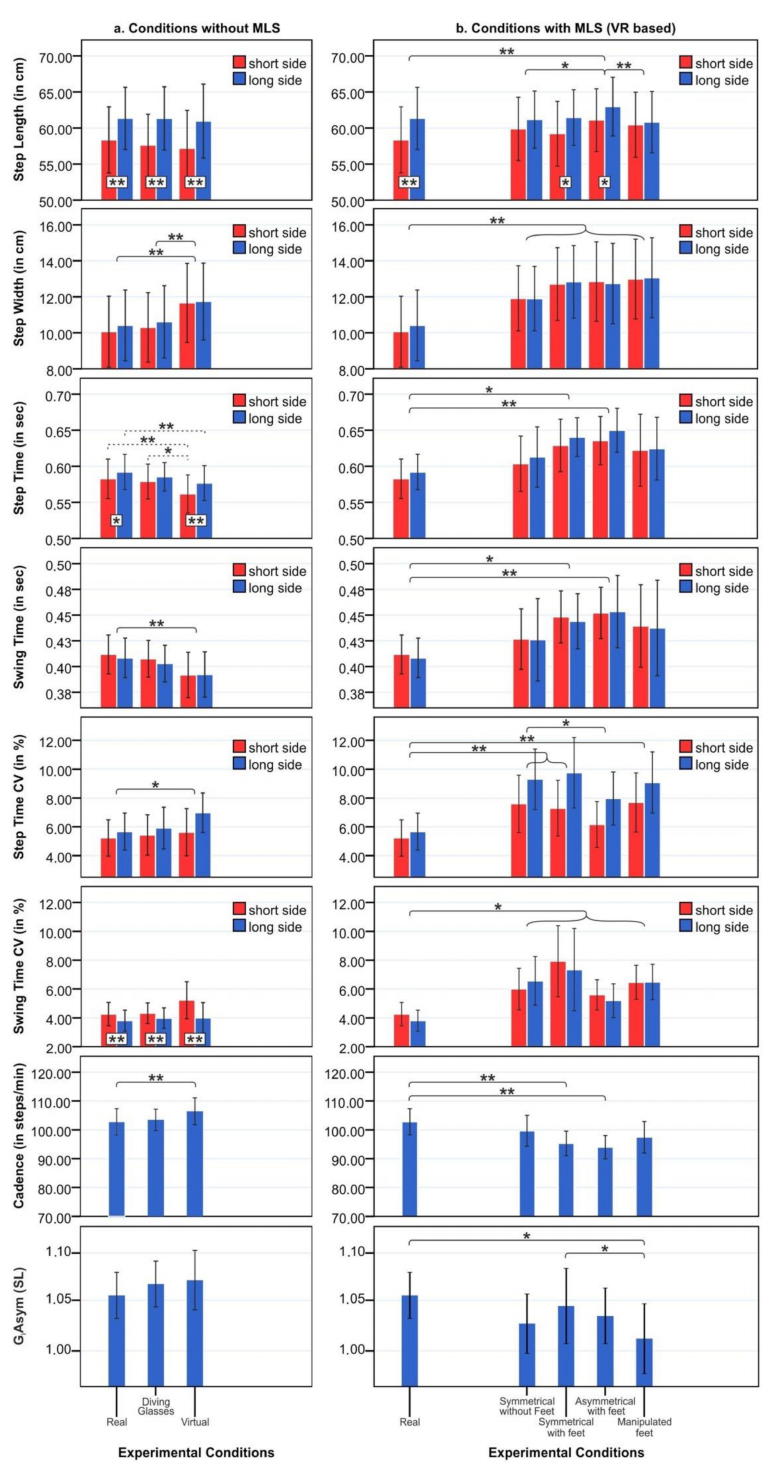
Figure 2. General gait parameters for ( a ) “Conditions without motor learning strategies (non-MLS)” and ( b ) “Conditions with MLS (“VR-based”, MLS)” are given as mean values +/ - standard error of mean. Significant di ff erences are marked as follows: (*) = p < 0.05, (**) = p < 0.01 and (***) = p < 0.001. = significant di ff erence between short and long side = significant di ff erence between di ff erent gait modulations conditions for short and long sides = significant di ff erence between gait modulations conditions for either the short or the long